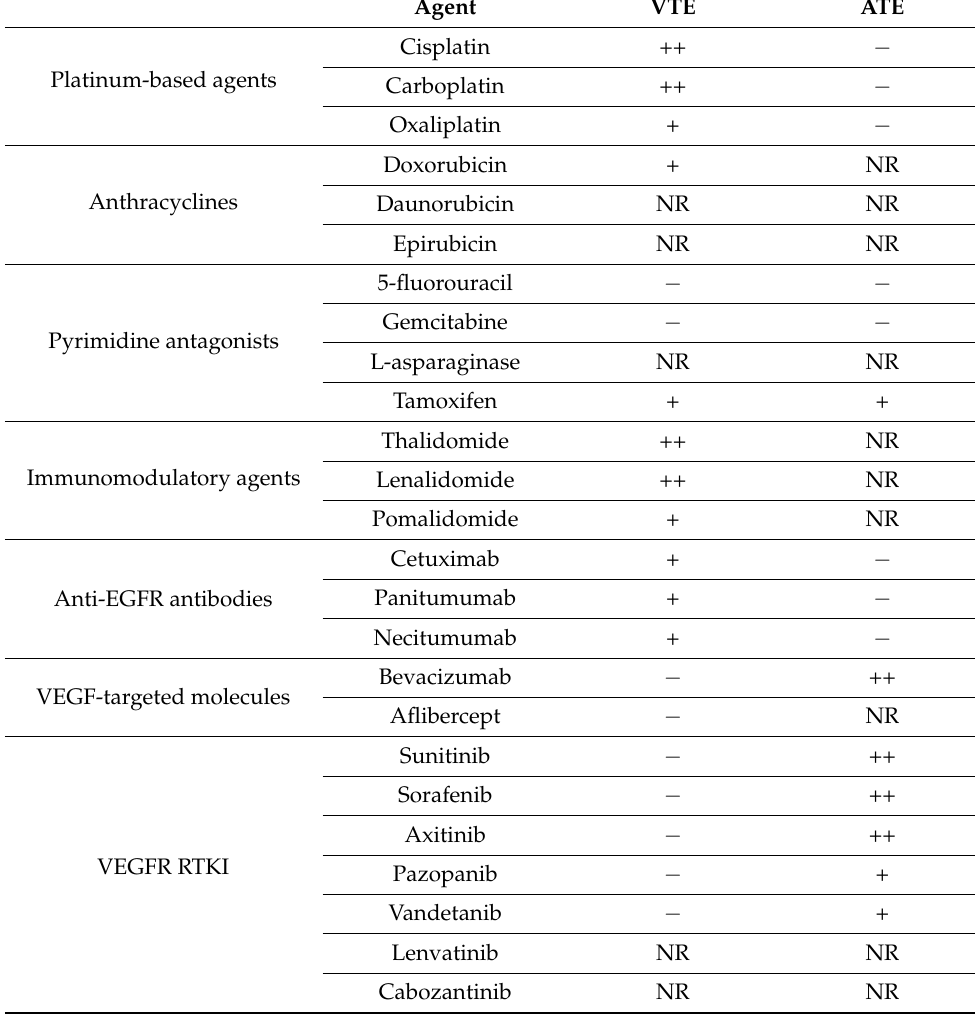
Table 1. The Khorana score for estimating venous thromboembolism risk in patients with cancer. Risk Factor Points Site of primary tumour Very high risk (stomach, pancreas) 2 High risk (lung, lymphoma, gynaecologic, bladder, testicular) 1 All other sites 0 Pre-chemotherapy platelet count ≥ 350,000/microL 1 Haemoglobin level < 10 g/dL or use of ESAs 1 Pre-chemotherapy WBC > 11,000/microL 1 BMI ≥ 35 kg/m 2 1